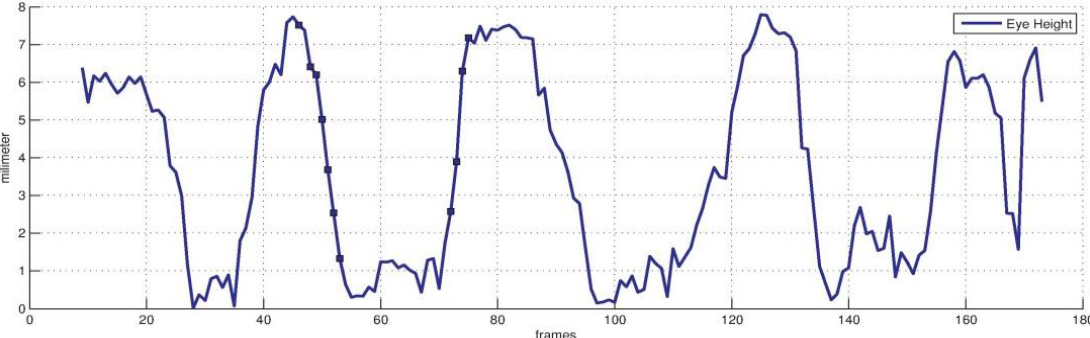
Figure 7. Eyelid distance curve in metric of millimetre.